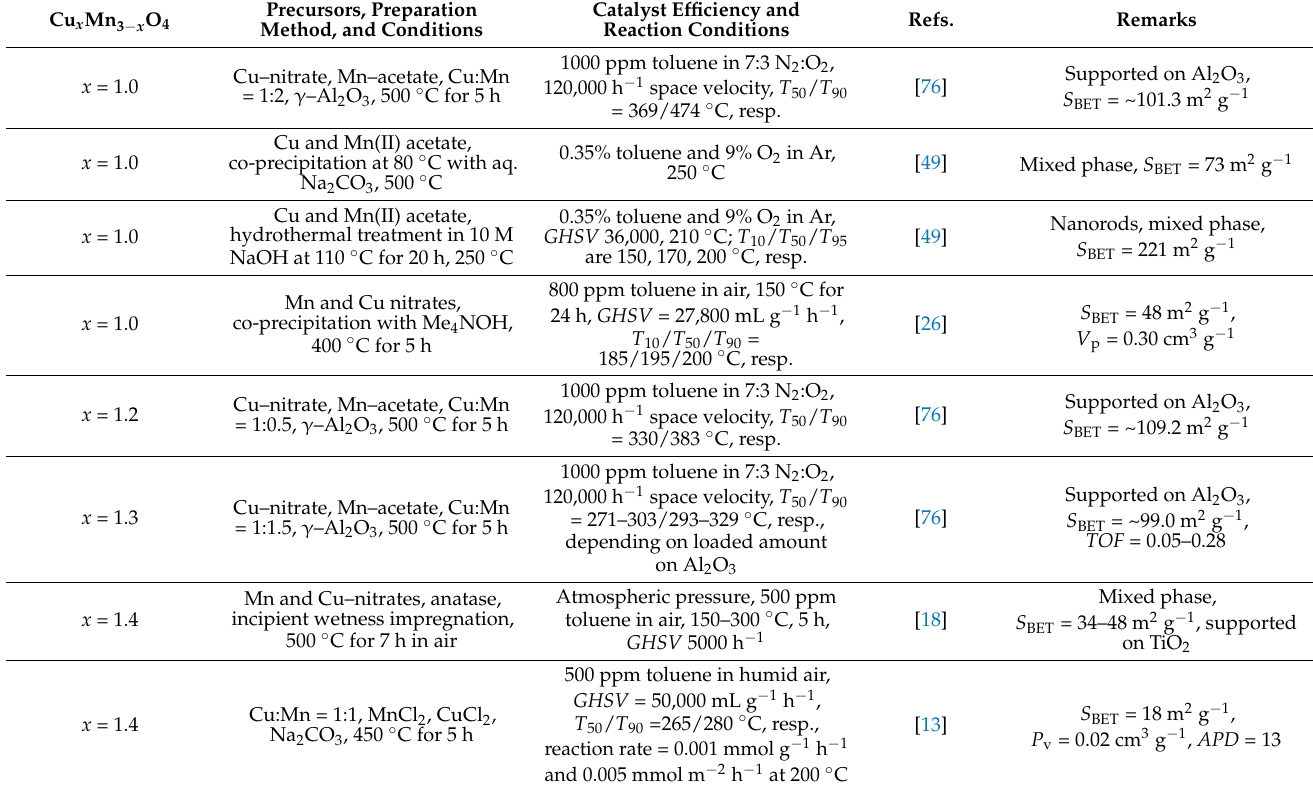
Table 9. Removal of toluene from air in the presence of Cu x Mn 3 − x O 4 catalysts. Cu x Mn 3 − x O